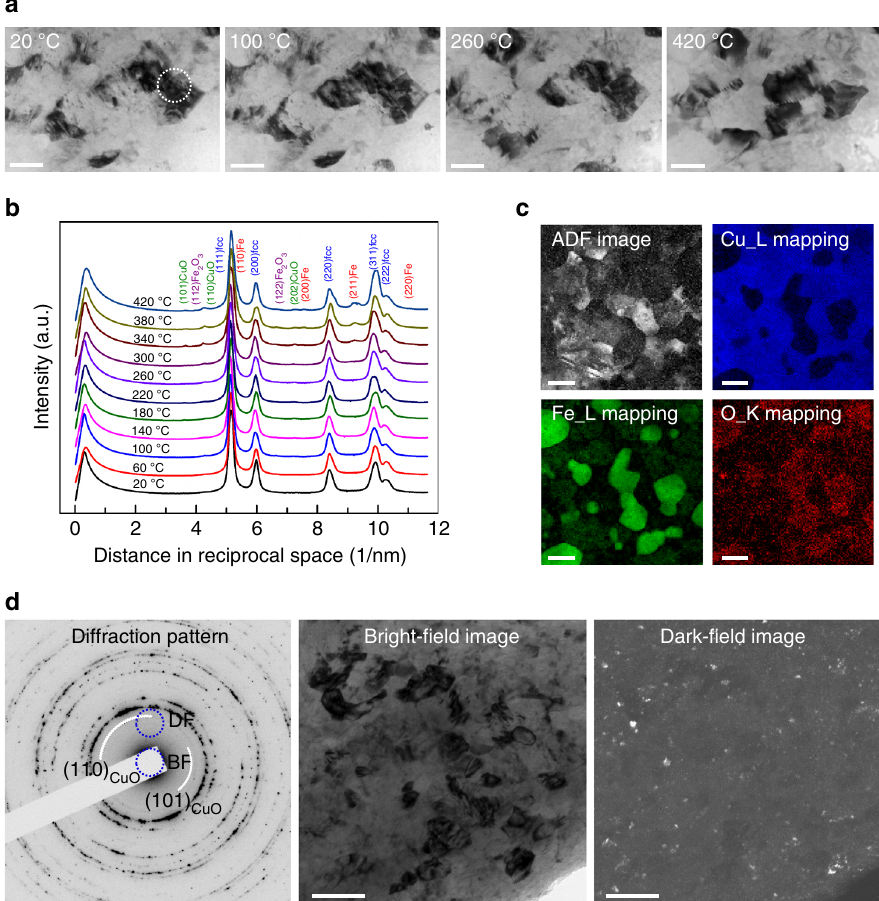
Fig. 1 TEM images and diffraction patterns for in situ heated samples. a Low magni fi cation images focusing on the same area recorded at different temperatures. b Integrated pro fi les of diffraction patterns of the same area. c ADF image and corresponding elemental distributions using EELS mapping of Cu_L 2,3 , Fe_L 2,3 and O_K edges for the sample after in situ annealing at 420 °C. d Diffraction pattern of the sample in situ annealed at 420 °C, the corresponding BF and DF images forming from partial diffractions as schematically illustrated in the left diffraction pattern with blue circles. The scale bars in ( a , c ) are 50 nm and in ( d ) is 100